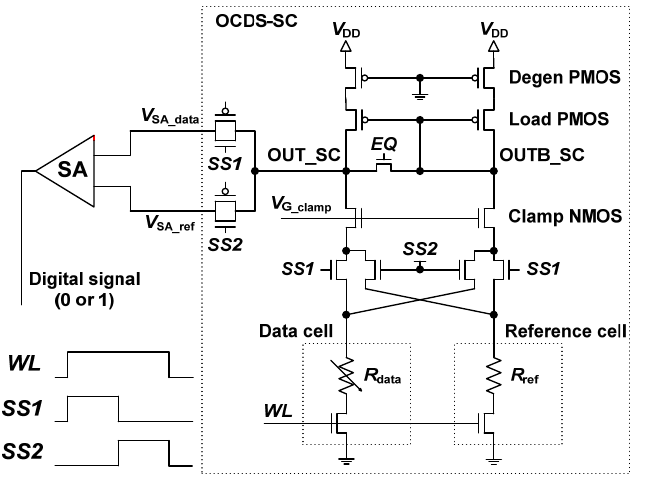
Figure 2. Schematics of the OCDS-SC and symbolized sense amplifier (SA).